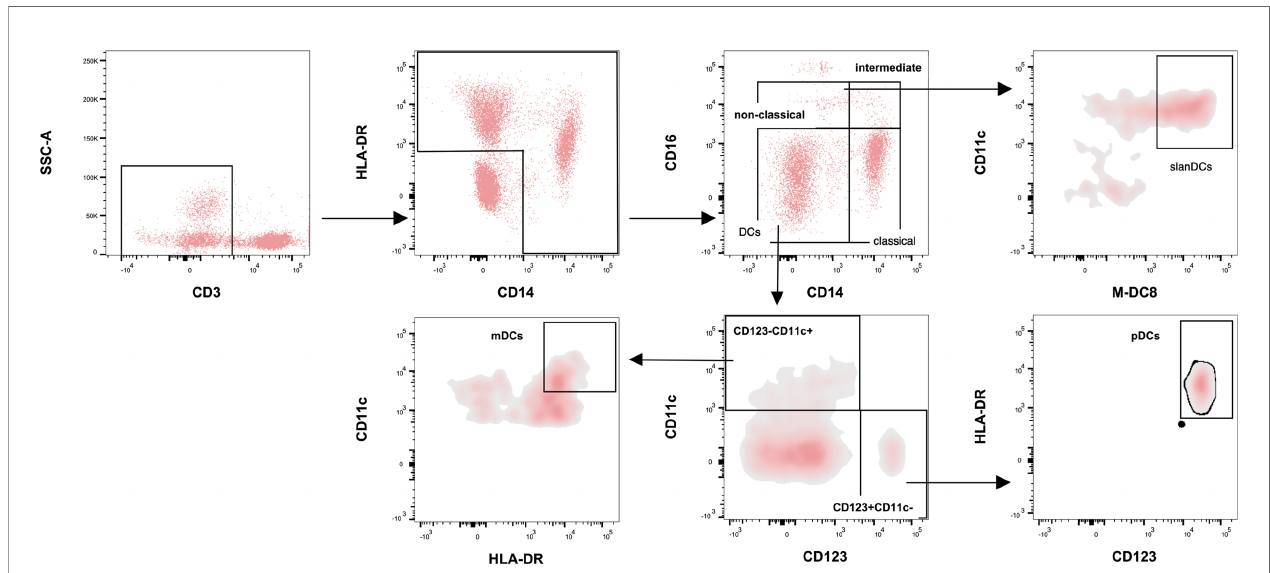
FIGURE 1 | Flow cytometry strategy for monocyte and dendritic cell (DC) subsets. Figure shows monocyte subsets characterization after exclusion of CD3+ and HLA-DR-CD14- cells. According to CD14 and CD16 expression, monocytes were de fi ned as non-classical (CD14+CD16+), intermediate (CD14++CD16+), and classical monocytes (CD14++CD16-). The frequency of the slanDC cells was evaluated into the gate of non-classical monocytes, after gating the cells co-expressing M-DC8 and CD11c. Finally, in the CD14-CD16- gate, DC subsets were characterized according to the expression of CD123 and CD11c as CD123-CD11c+ and CD123+CD11c-. The frequency of mDCs was evaluated in the CD123-CD11c+ gate according to the high expression of CD11c and HLA-DR. The frequency of pDCs was evaluated in the CD123+CD11c- gate according to the high expression of CD123 and